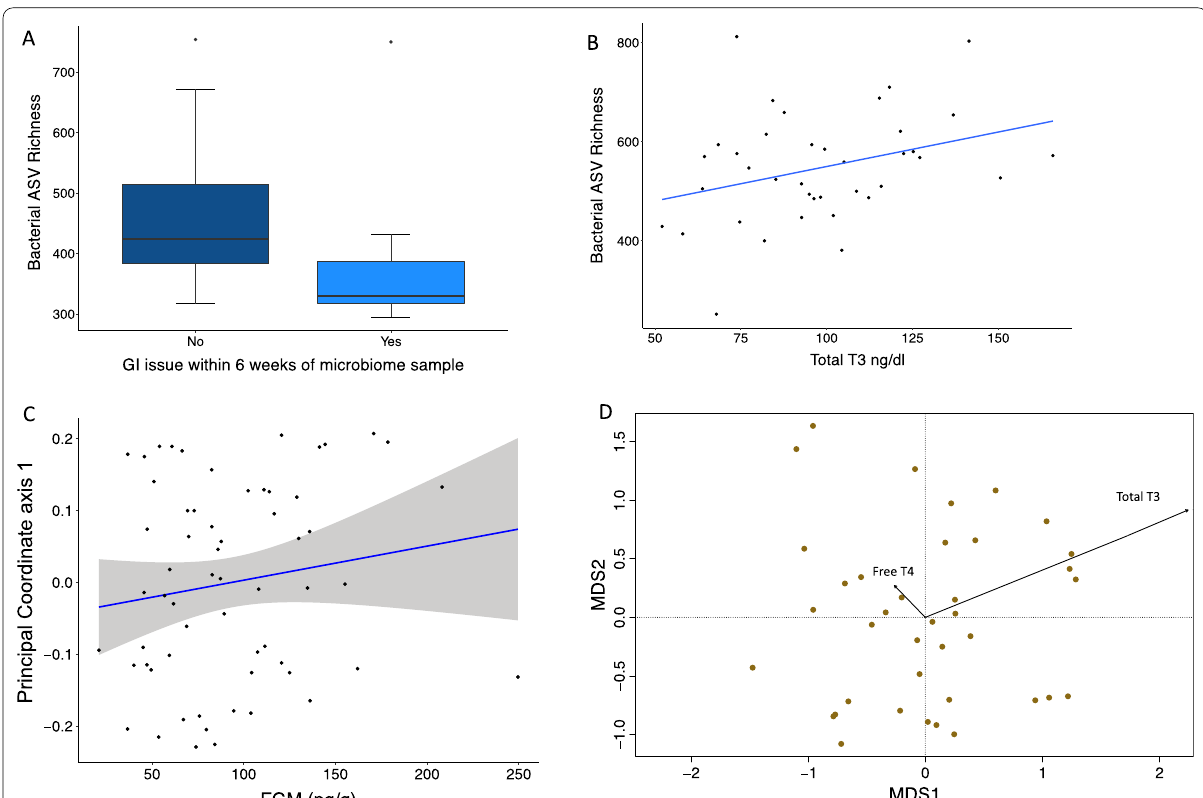
Fig. 4 Associations of microbiome structure with GI issues and hormone concentrations in African and Asian elephants. A African elephants with recent GI issues had lower bacterial ASV richness (LMM p In Asian elephants, bacterial richness increased with yearly averages of total T3 (Wald X2 p elephants was linked to changes in FGM concentration. Principal coordinate axis 1 from Unifrac distances plotted against FGM concentrations. D Thyroid hormones, total T3 and free T4, were significantly associated with gut microbiome composition of Asian elephants. Vectors on the MDS plot depict the correlation of total T3 and free T4 with the pattern in ordination space using Bray–Curtis distances. The length of the vector signifies the strength of the correlation (e.g. shorter arrows represent weaker